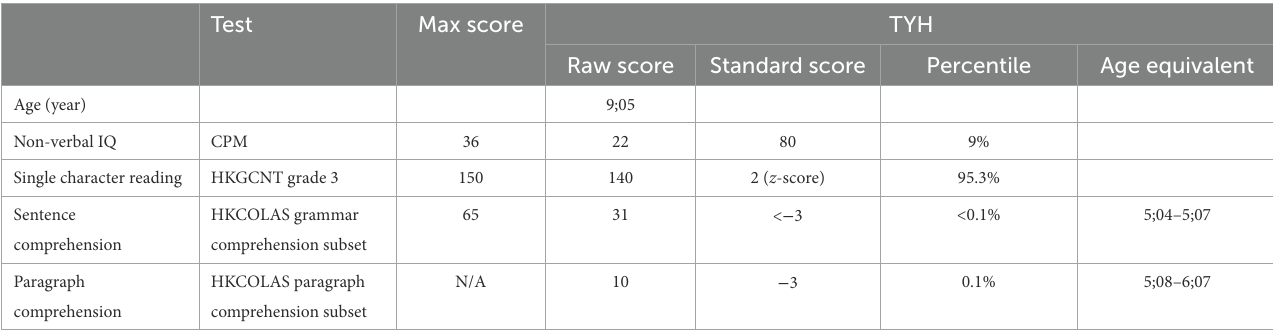
TABLE 1 Non-verbal IQ and standardized language assessment results of TYH and comparison with his chronological age